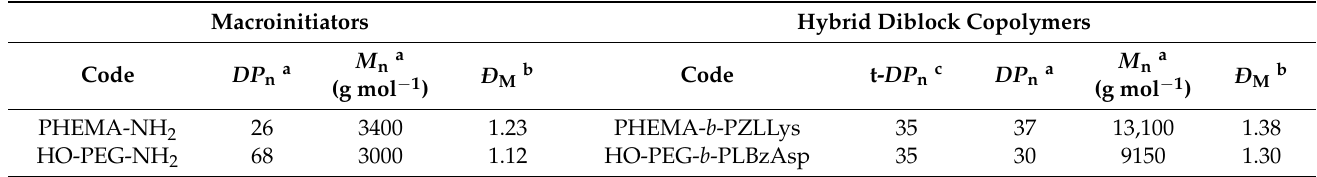
Scheme 1. Synthetic routes toward: ( a ) positively charged PHEMA- b -PLLys and ( b ) negatively charged LBA-PEG- b -PLAsp peptide-based hybrid diblock copolymers. Table 1. Molar mass characteristics of macroinitiators and the corresponding hybrid peptide-based diblock copolymers.